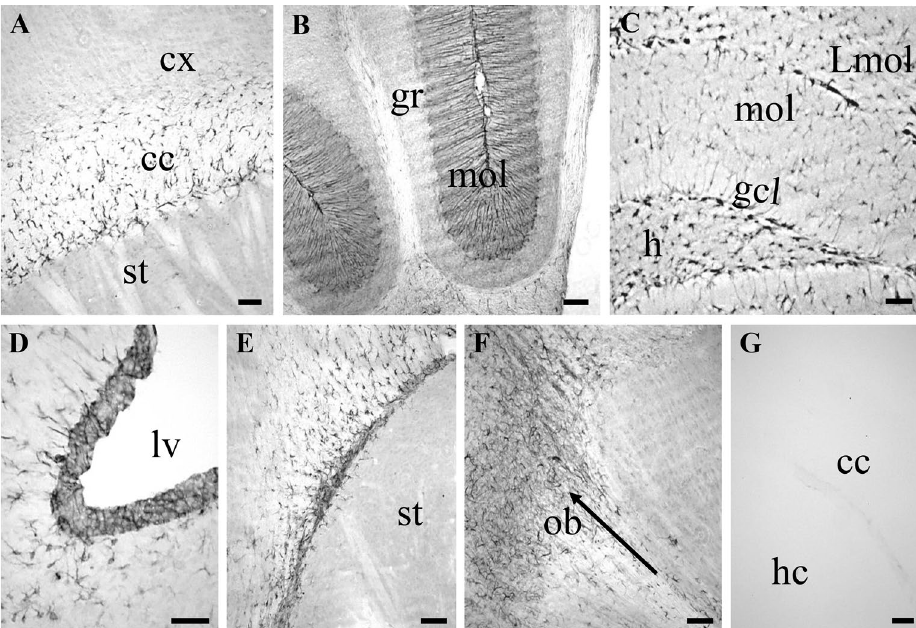
Figure 3. NSC-6 antibody immunolabels different adult mouse brain regions. ( A ) NSC-6 immunopositive glia-like cells in the corpus callosum (cc). Note the absence of NSC-6 immunolabeling in the cortex (cx) and the striatum (st). ( B ) NSC-6 immunolabeling of Bergmann glia processes in the molecular layer (mol) of the cerebellum. The granular layer (gr) lacks NSC-6 immunolabeling. ( C ) NSC-6 labels sparse astrocytes-like cells in the hilus (h), the molecular layer (mol), and the lacunosum moleculare layer (Lmol) of the dentate gyrus. Radial-astrocyte processes—most likely belonging to NSCs due to their perpendicular orientation— in the granule cell layer (gcl) are also immunolabeled. ( D ) NSC-6 immunolabeling of the SVZ adjacent to the lateral ventricle (lv) and surrounding parenchyma. ( E ) NSC-6 immunolabeling of the RMS. Note the absence of staining in the striatum (st). ( F ) NSC-6 immunolabeling of the rostral aspect of RMS, entering and disseminating in the olfactory bulb (ob). The arrow points the rostral direction. ( G ) Omission of the primary antibody resulted in absence of detectable immunolabeling throughout the entire brain. The corpus callosum between the cortex (cx) and hippocampus (hc) is shown. Scale bars are 50 µm in all